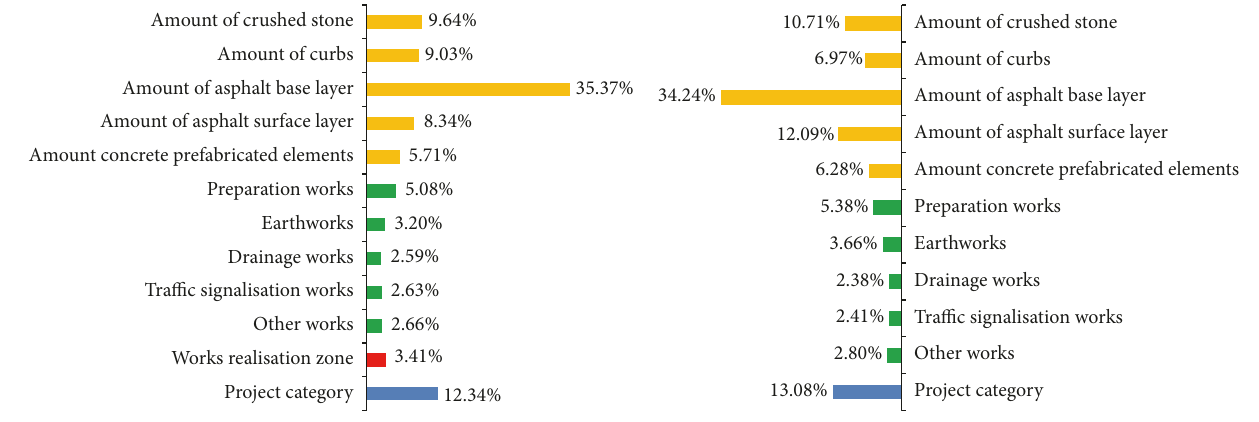
Figure 1: Analysis of sensitivity (ANN 3 and ANN 4); estimation of construction costs.